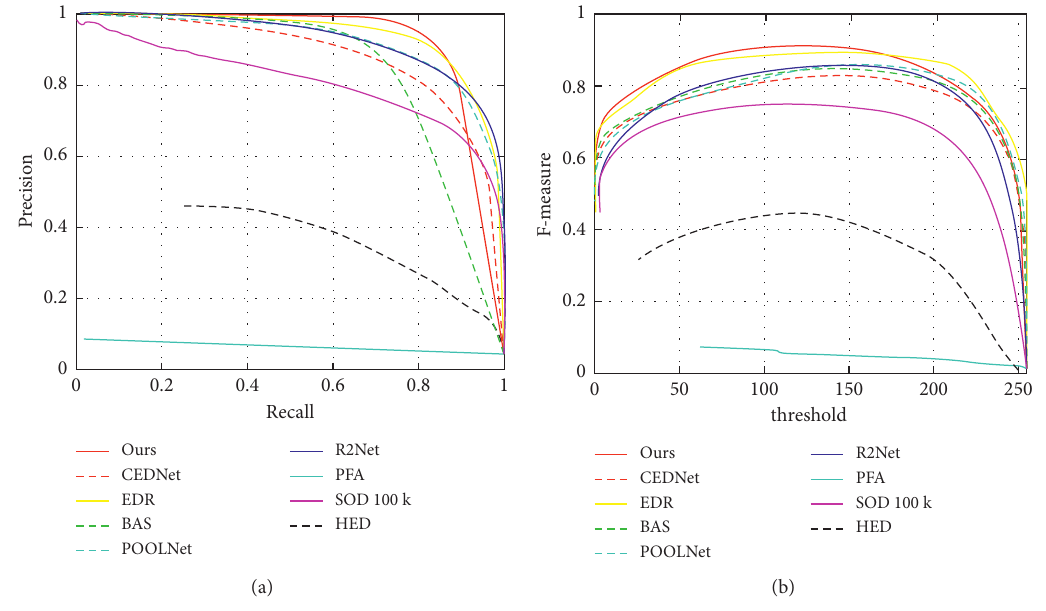
Figure 14: Performance comparison diagram of each algorithm. (a) Precision-recall curves. (b) F -measure